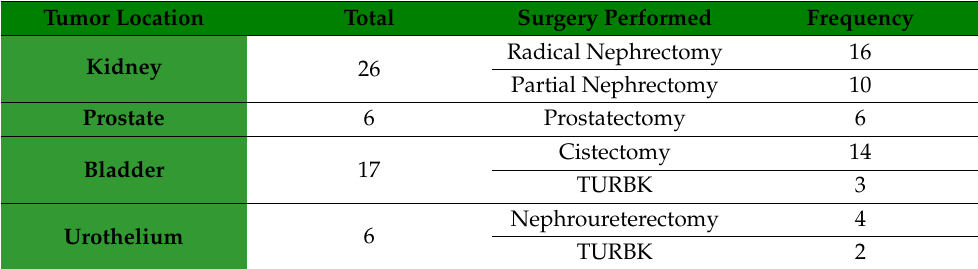
Table 2. Occurrence of urological cancers in the CS cohort. The total of the neoplasms present in the population (n = 55) is bigger than the number of patients (n = 51) because some patients had two primitive tumors in different locations, not as a consequence of metastasis.